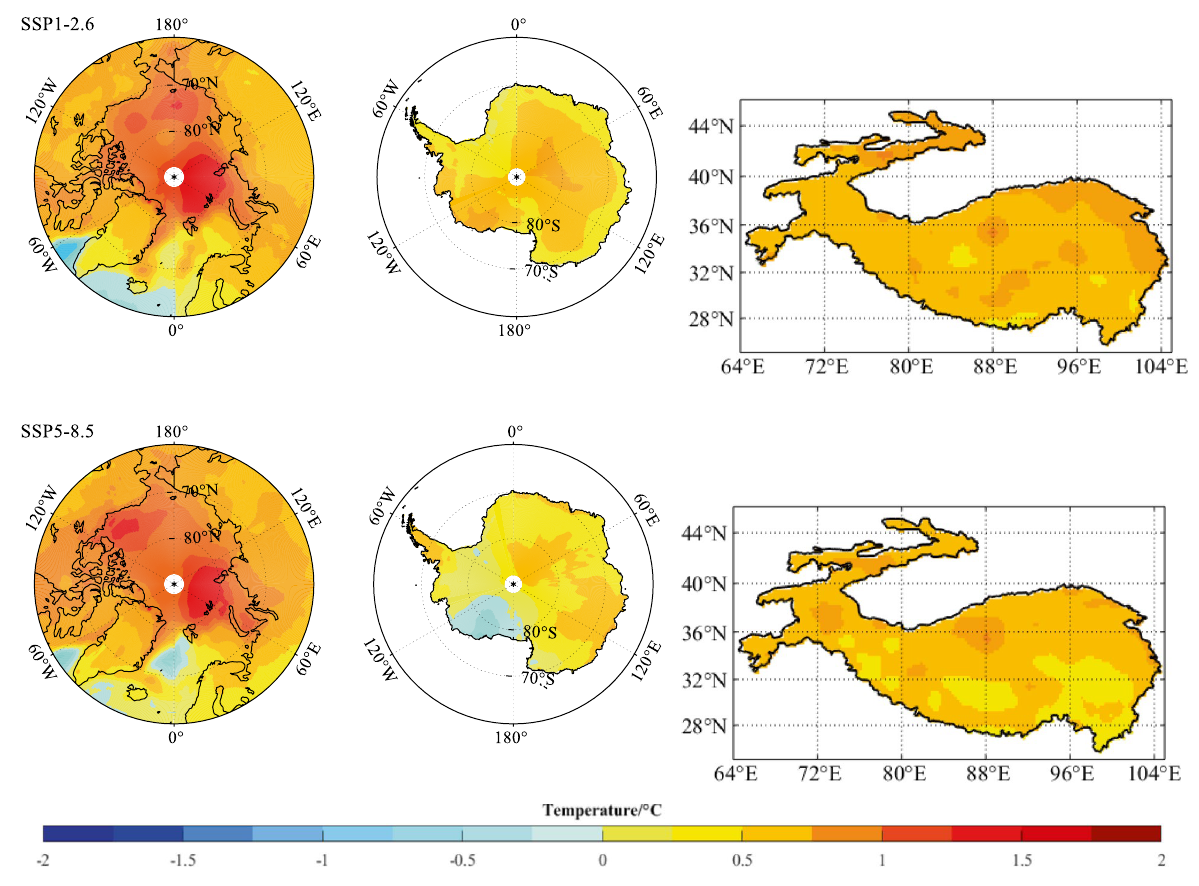
Figure 7. Spatial patterns of annual mean temperature difference (°C) over Arctic, Antarctica and The Third Pole from the CMIP6 simulations MMEM when global warming reaches 1.5 °C and 2.0 °C threshold above pre-industrial levels only under SSP1-2.6 and SSP5-8.5. The map was drawn in the software MATLAB R2018b (https:// ww2. mathw orks. cn/ produ cts/ matlab.